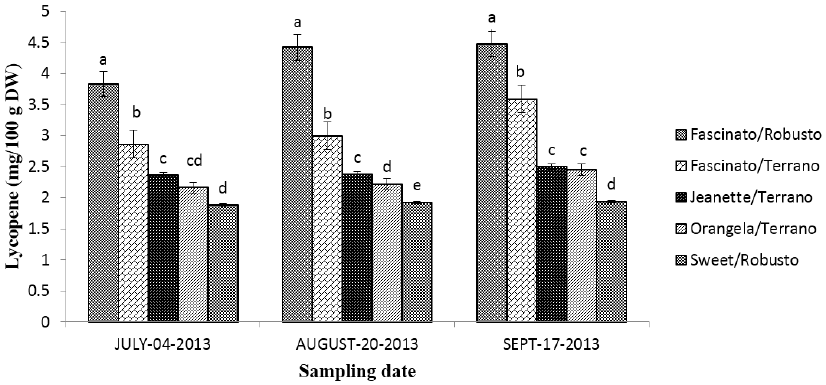
Figure 9. Lycopene content in grafted bell peppers harvested on three different sampling dates. a–e Different letters indicate statistical difference ( p ≤